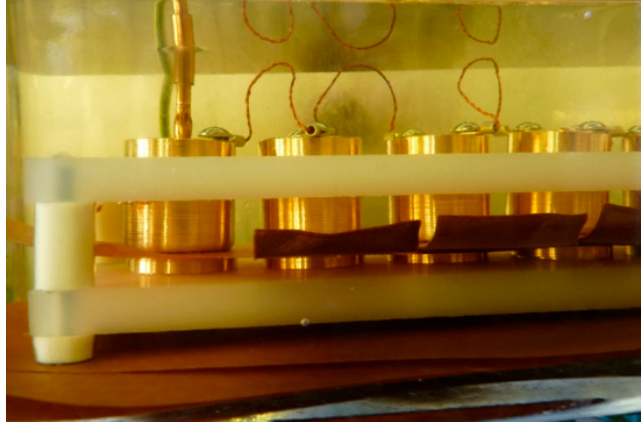
Figure 1. Electrode system for long ‐ term electric stress.